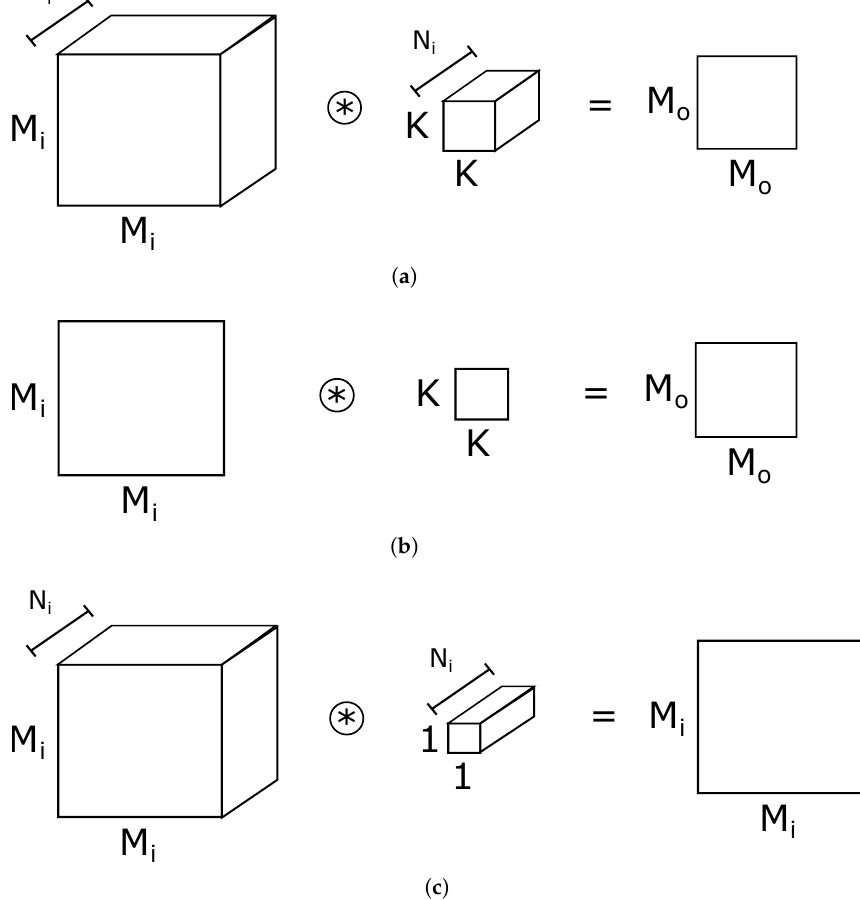
Figure 1. Convolution types in MobileNet V2. ( a ) standard convolution; ( b ) depthwise convolution; ( c ) expansion/projection